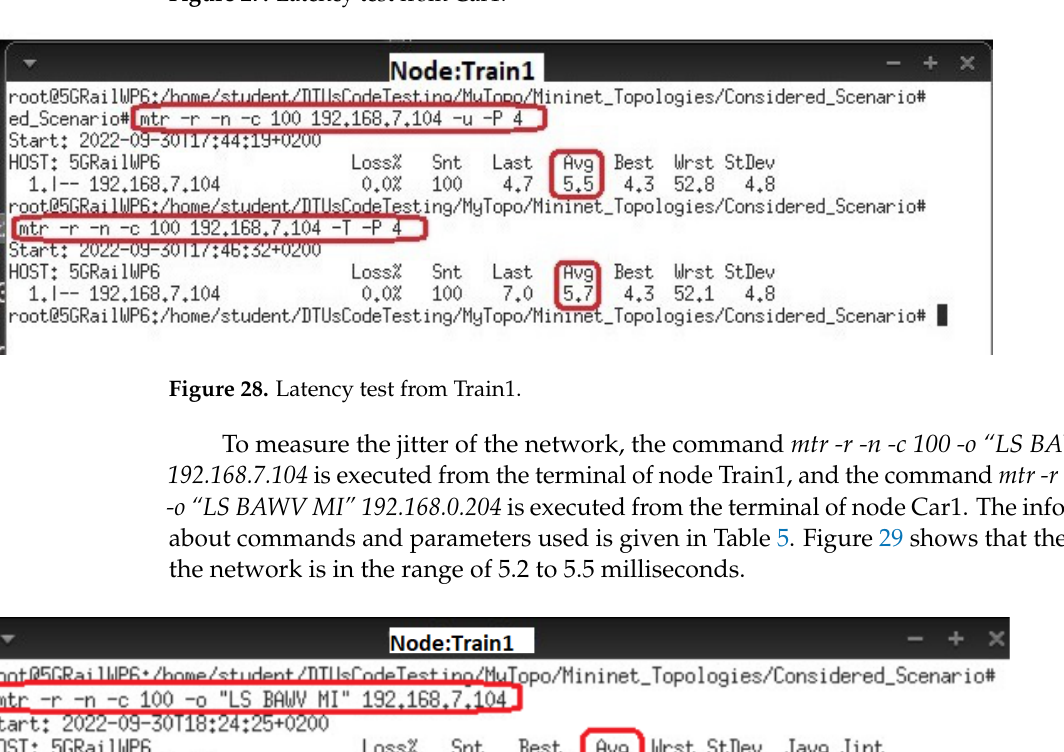
Figure 27. Latency test from Car1.